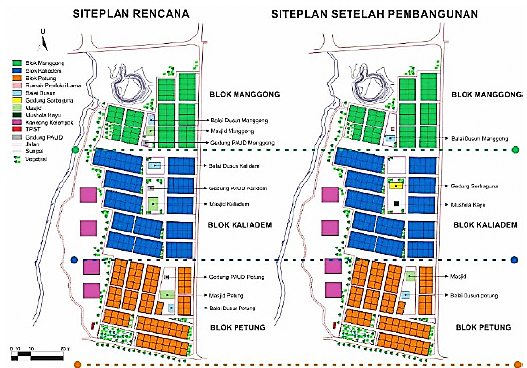
Figure 5. Place of worship